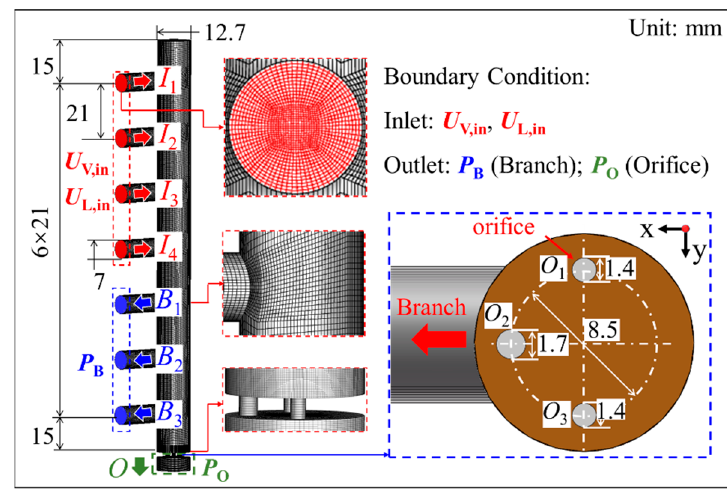
Figure 2. Scheme of the header and the boundary conditions.